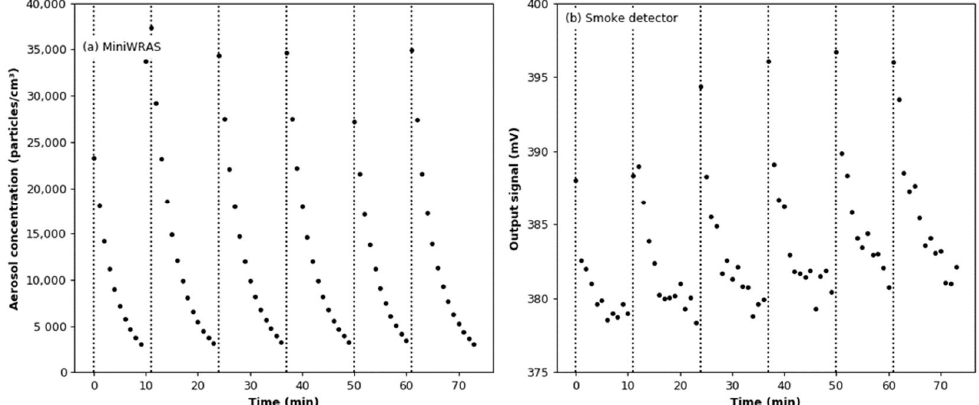
Figure 16. Readings from the aerosol detectors during the soot effect test under variable humidity conditions: ( a ) total particle number concentrations measured by the MiniWRAS; ( b ) output signal from the smoke detector.